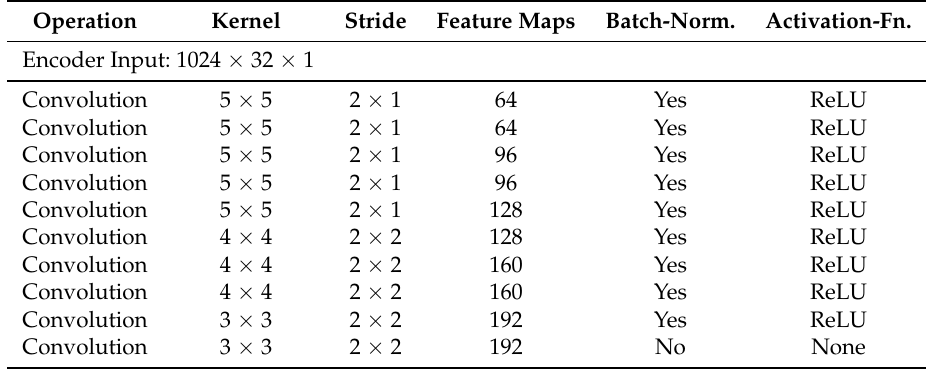
Table A1. Implementation